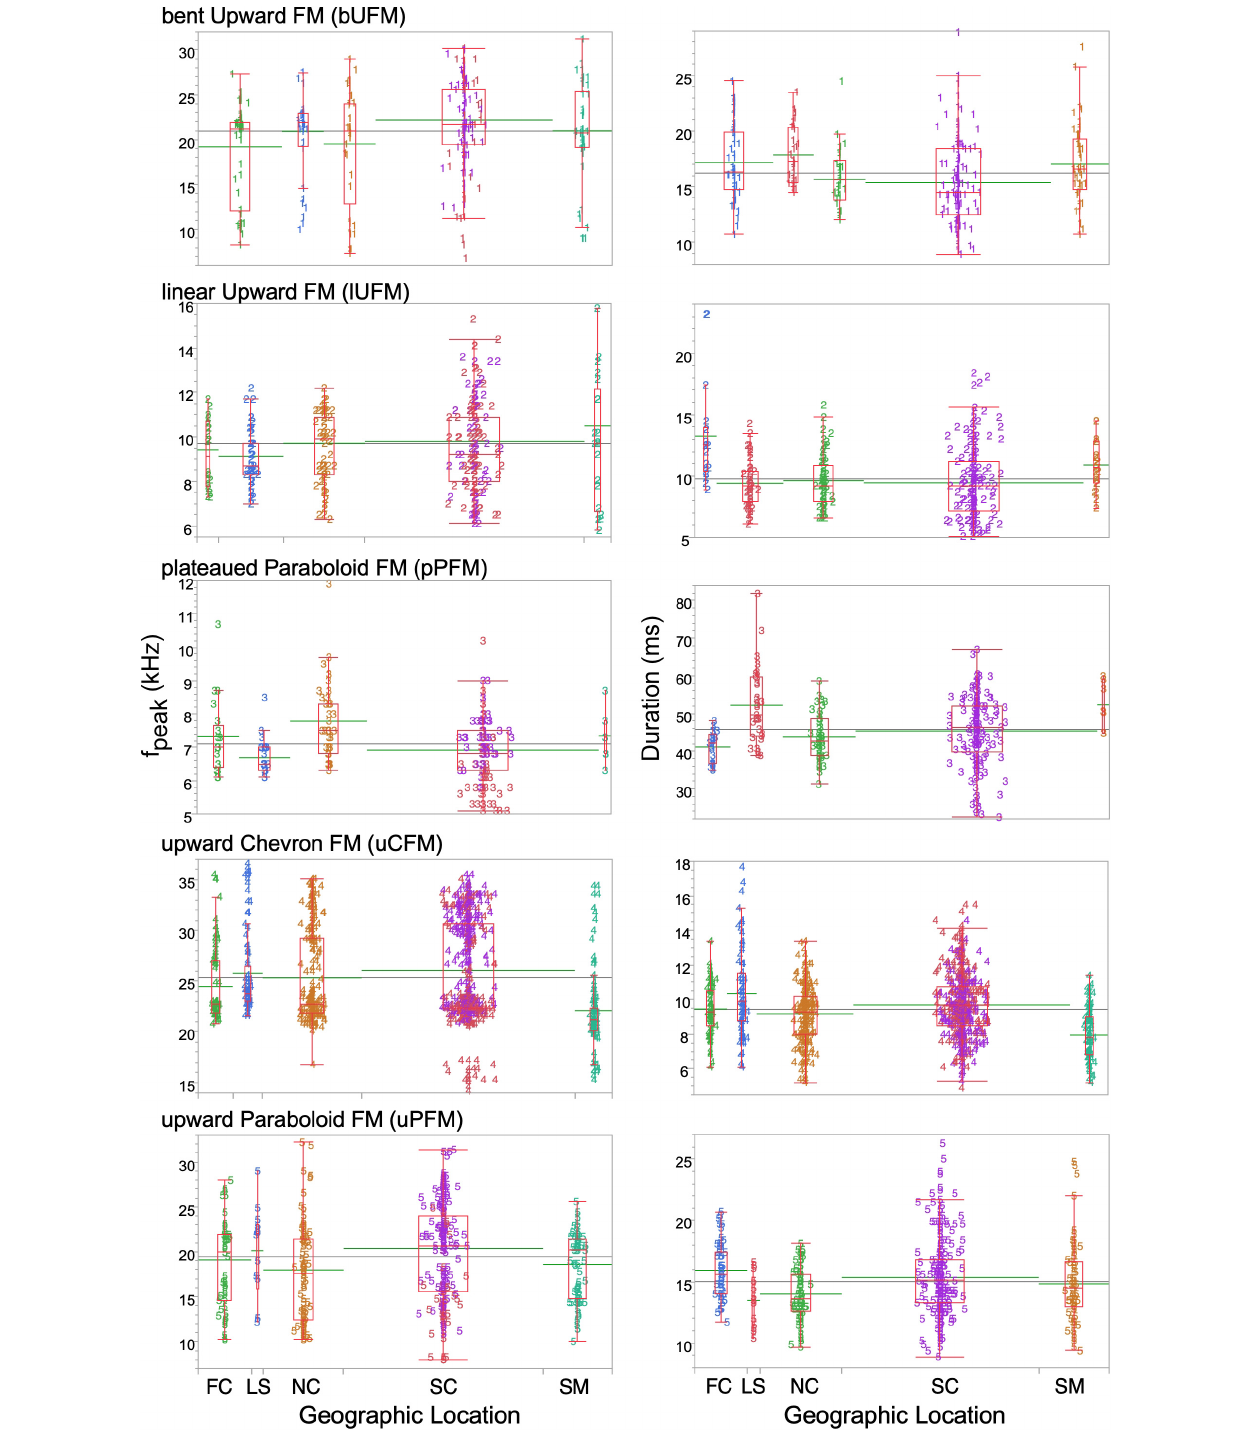
FIGURE 2 | Side-by-side box and whisker plots showing the mean and standard deviation of f peak and duration parameters in five syllable types tested for analysis of geographic variation in this study. Numbered markers indicate parameter observations for syllable types and colors indicate geographic regions from where they were recorded. FC and SM regions in the far northeast and far southwest, respectively, show the maximum divergence from the grand mean (gray line) of the medians (green lines) for nearly all syllables, suggesting that geographic distance can increase difference between means. A systematic pattern of difference between means proportional to geographic distance, however, is absent. The width of the box plots is based upon the number of data points at each location. See Table 1 for statistical significance of differences between geographic regions.